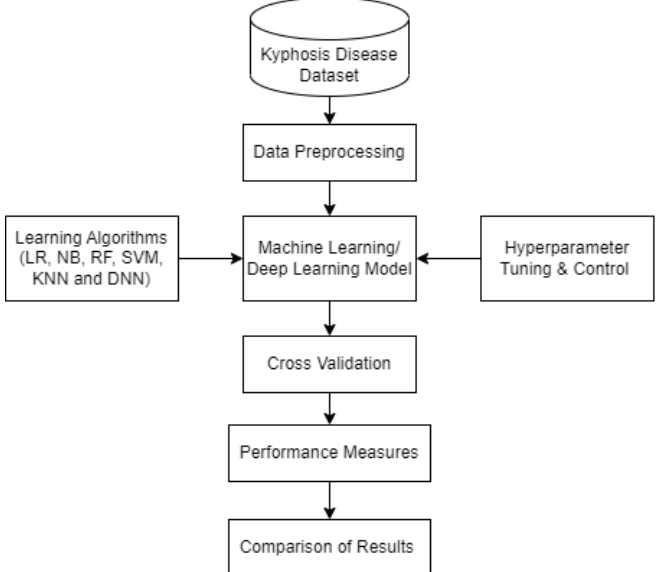
Figure 1. The framework of the proposed system for detecting Kyphosis disease.